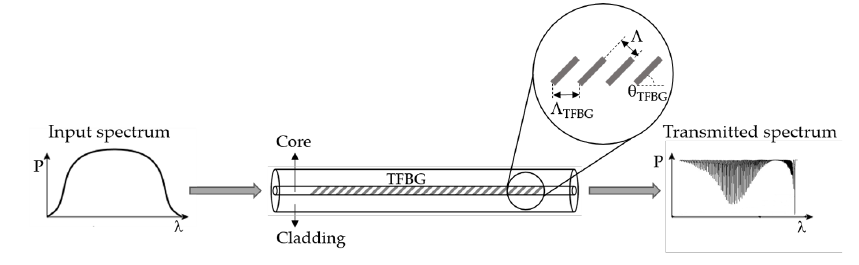
Figure 4. Schematic representation of a TFBG.